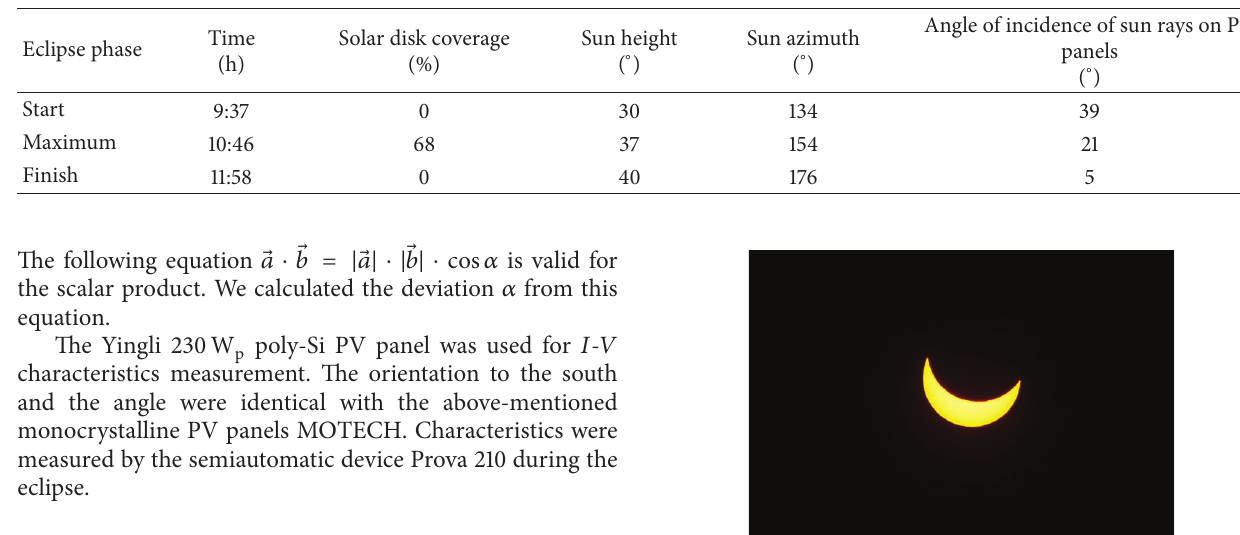
Figure 1: Our PV system used for data monitoring during the solar eclipse. Table 1: Selected values of important variables during the solar eclipse on March 20, 2015.